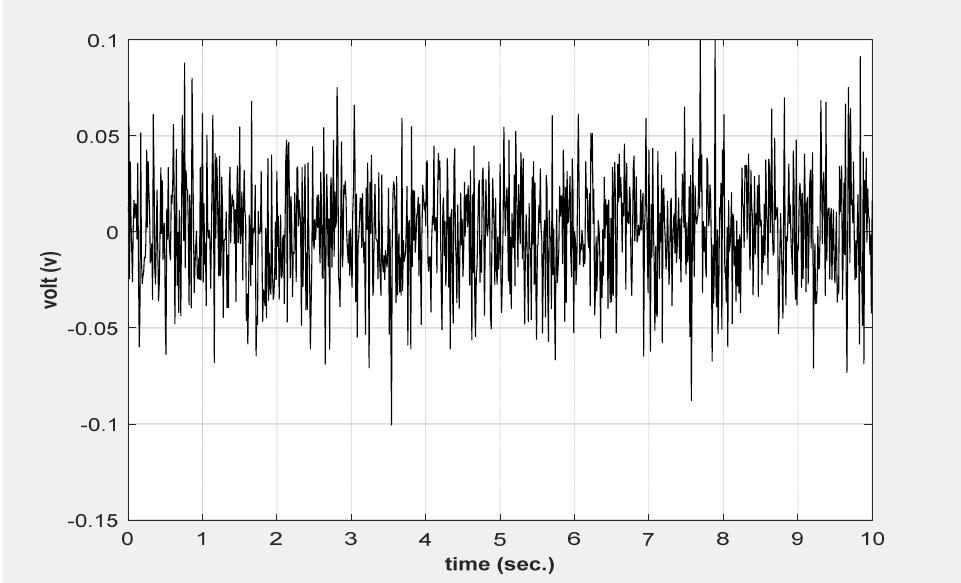
Figure 25. Disturbance signal.